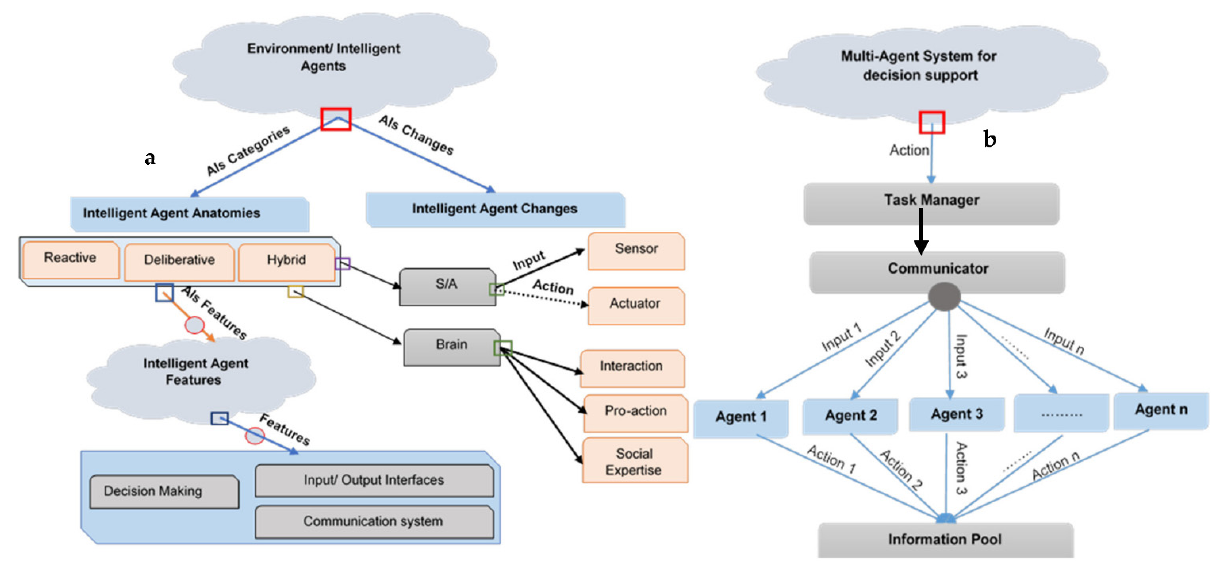
Figure 5. Intelligent Agent Model: ( a ) Agent Types; ( b ) Agent tasks.